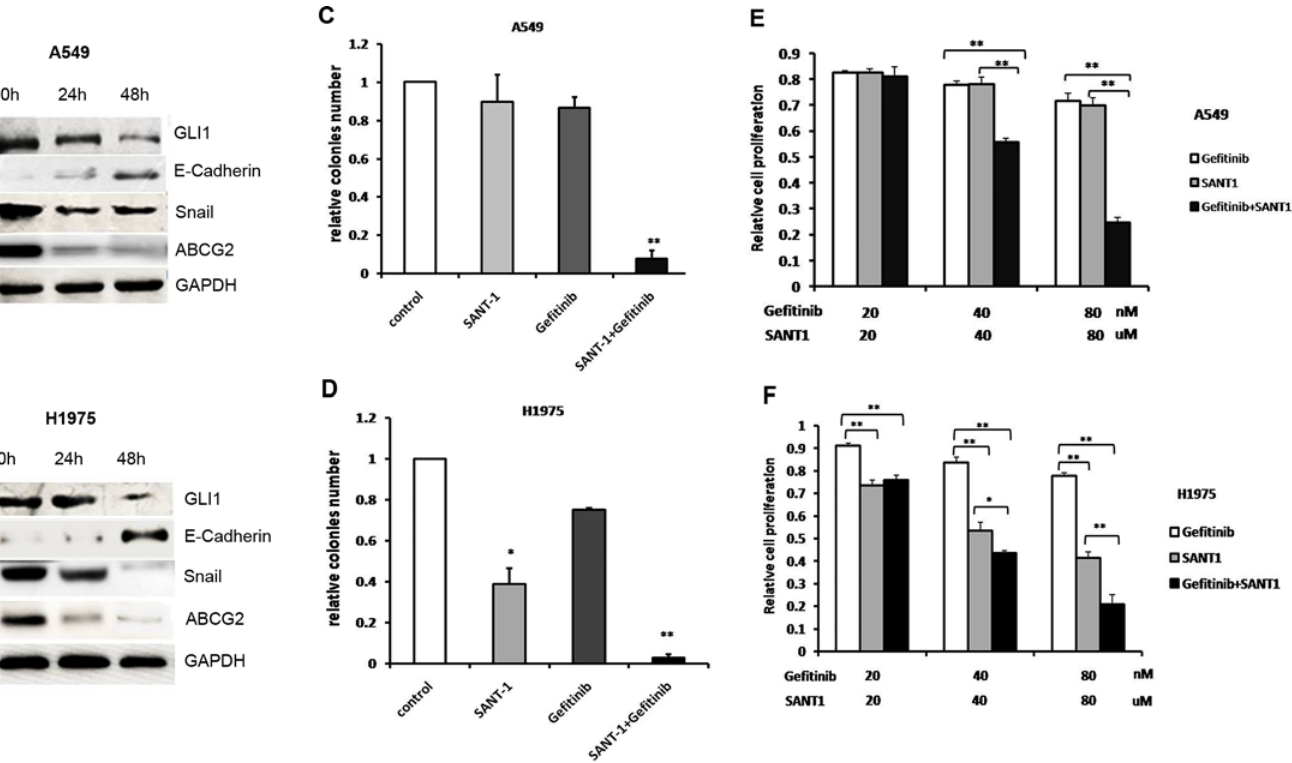
Fig 3. Hh inhibition reversed EMT and decreased the ABCG2 expression in EGFR-TKI-resistant NSCLC cells and the combination of gefitinib and SANT1 synergistically inhibited tumorigenesis and proliferation in EGFR-TKI-resistant NSCLC cell lines. (A) and (B), Western blot analysis of the Hh signaling pathway activity and its target genes E-Cadherin, Snail and ABCG2 in EGFR-resistant cells A549 and H1975 after SANT-1 treatment for 0, 24, and 48 h. (C) and (D), colony formation quantitative analysis in A549 and H1975 cells; gefitinib alone or SANT1 alone did not inhibit clonogenic growth effectively. However, colonies very barely formed in the group subjected to combined SANT-1 and gefitinib treatment in A549 and H1975 cells; * ( P < 0.05), ** ( P < 0.01). (E) and (F), Proliferation of A549 and H1975 cells was assessed by MTT assay after treatment with the indicated concentrations of gefitinib alone, SANT-1 alone, or the combination of gefitinib and SANT-1; * ( P < 0 . 05) , ** ( P < 0 . 01